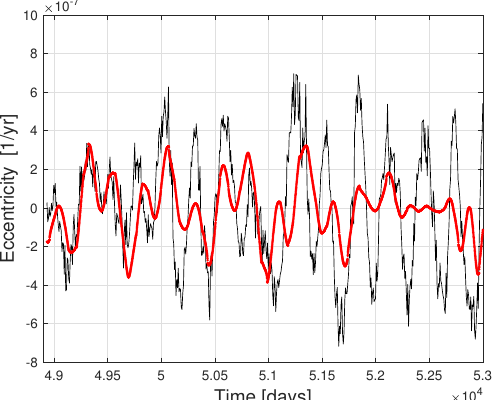
Figure 9. Yarkovsky-Schach effect on the rate of change of LAGEOS II eccentricity. The predictions of the simplified thermal model (red line) are compared with the residuals in the eccentricity (black line) obtained by means of a POD performed over the same time span of 4080